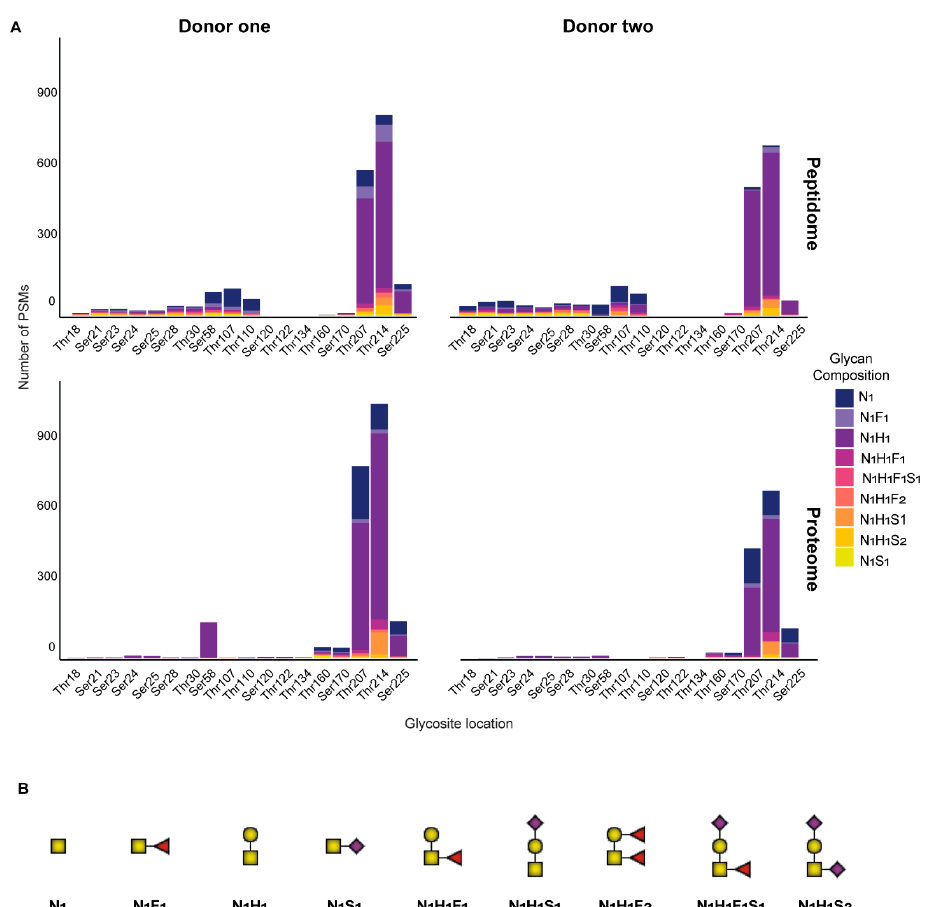
Figure 6. Site analysis of glycan species identified across the peptidome and proteome in each of the donors. ( A ) The glycan species are displayed for the peptidome and proteome at all possible Ser and Thr sites across the protein backbone for donors one and two. Glycan species are displayed as stacked bars of PSMs per site, with each glycan species represented with a different color. The sites Thr207 and Thr214 in the peptidome and proteome have the highest number of O-glyco-PSMs and are occupied by primarily N 1 and N 1 H 1 glycans. ( B ) Schematic representations of the nine different O -glycans identified on human β -casein. Our MS method did not distinguish structural elements of the glycosylation, and the representations only inform on the composition of the glycan species.